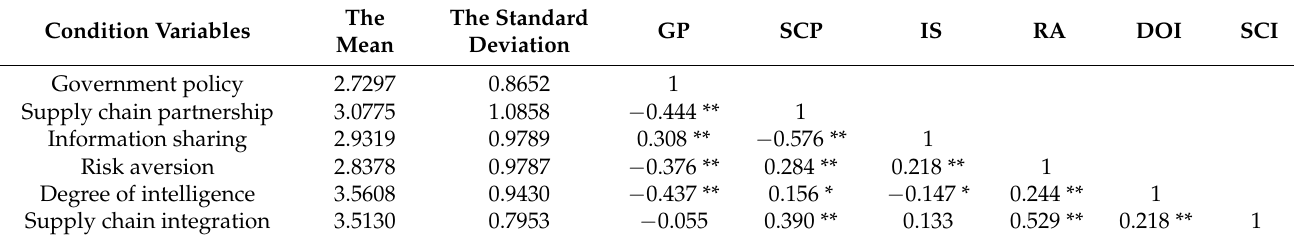
Table 2. Descriptive statistical analysis